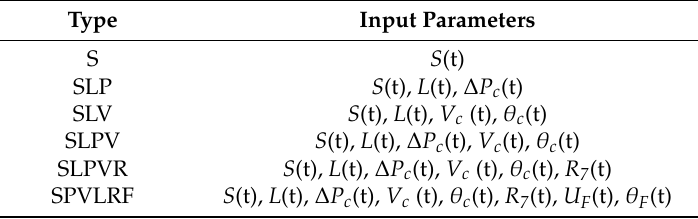
Figure 2. ( a ) Sketch of e ff ective controlling parameters for storm surge prediction; ( b ) architecture of the back-propagation neural network. Table 2. Six combinations of e ff ective controlling parameters for storm surge